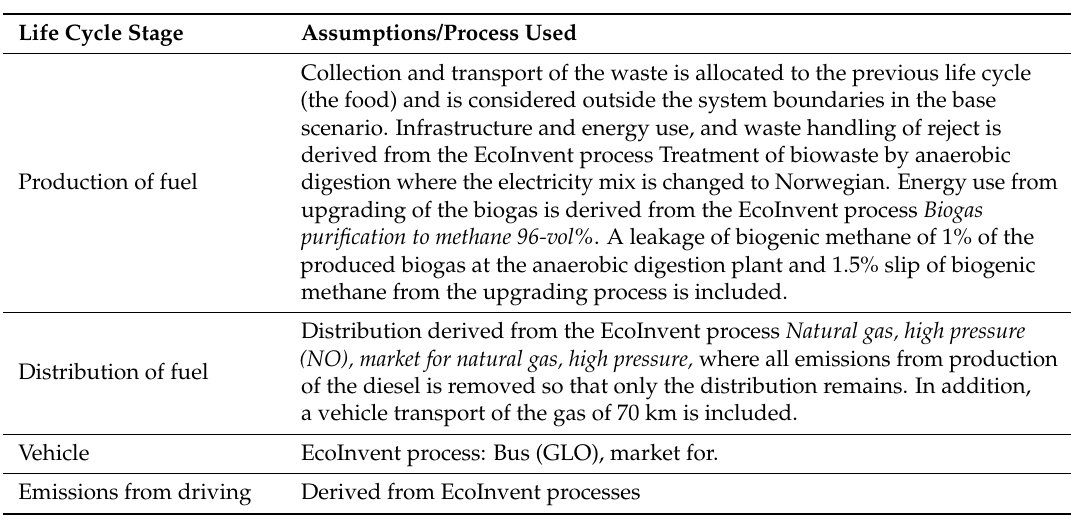
Table A1. Biogas from food